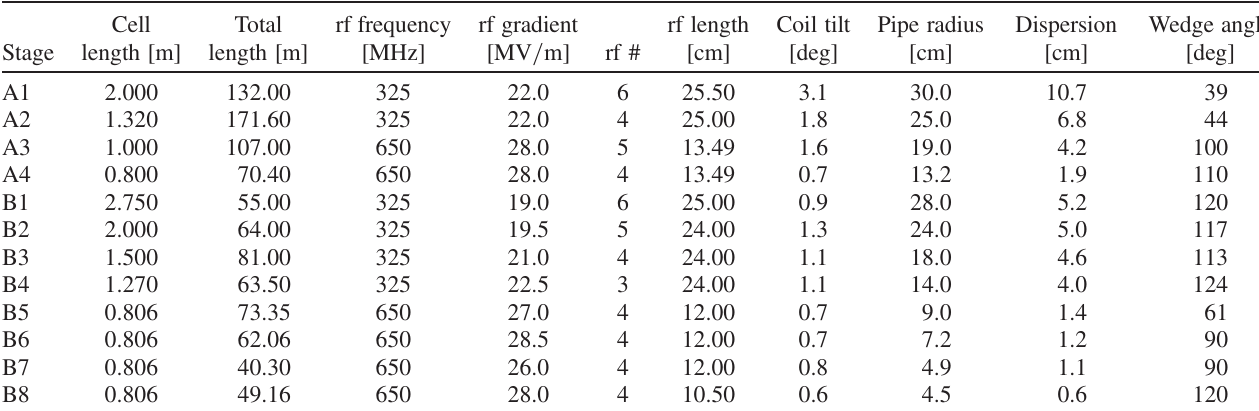
TABLE I. Main parameters of a 12-stage rectilinear 6D cooling lattice before and after recombination. Stages A1 – A4 and B1 – B4 use LH absorber while stages B5 – B8 use LiH absorber. Dispersion is calculated at the absorber center at the reference momentum of 200 MeV =c .